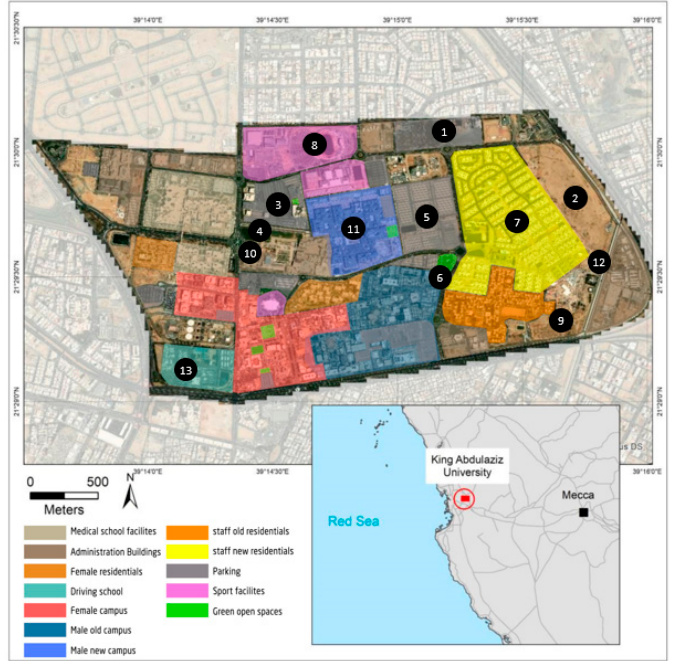
Figure 1. Study area. Land 2020 , 9 , x FOR PEER REVIEW